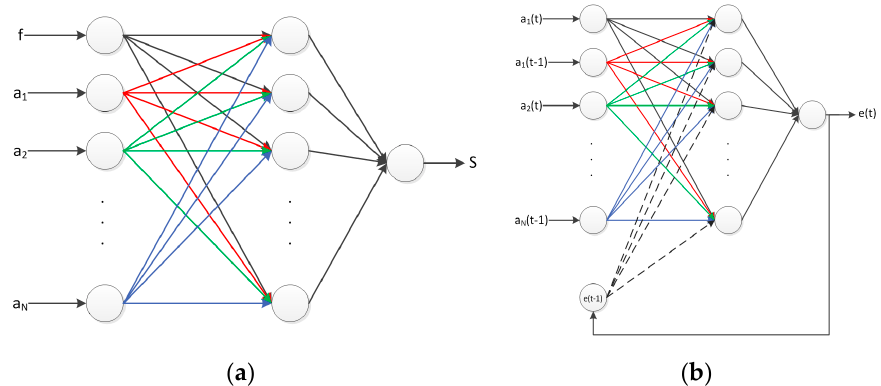
Figure 3. Architecture of the considered ANN: ( a ) frequency-dependent ANN and ( b ) nonlinear autoregressive exogenous (NARX) model.